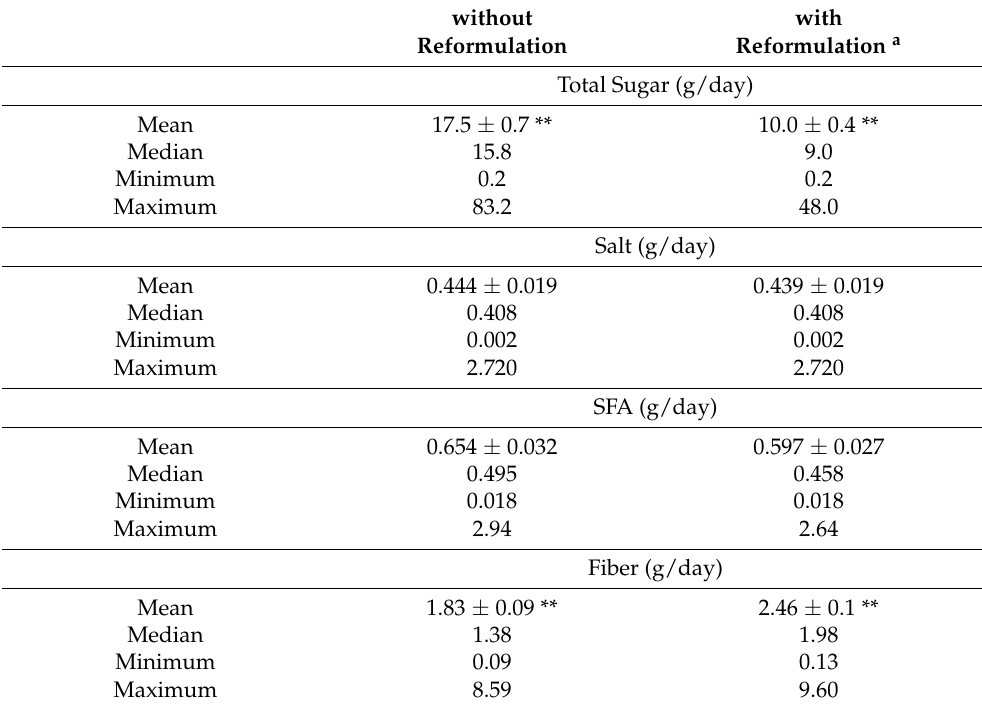
Table 4. Estimated intake of total sugar, salt, saturated fatty acids (SFA), and dietary fiber through the consumption of RTECs by the Portuguese children population, considering reformulation (estimates considering the children consumption). without with Reformulation Reformulation a Total Sugar (g/day) Mean 17.5 ± 0.7 ** 10.0 ± 0.4 ** Median 15.8 9.0 Minimum 0.2 0.2 Maximum 83.2 48.0 Salt (g/day) Mean 0.444 ± 0.019 0.439 ±